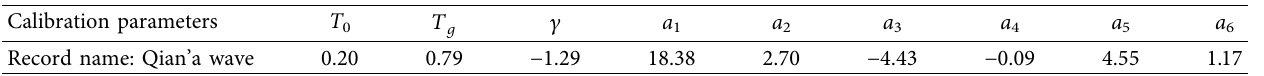
Figure 6: Calibration comparison of Qian’a design spectrum curves. Table 3: Design spectrum calibration parameters calibrated by the new method.